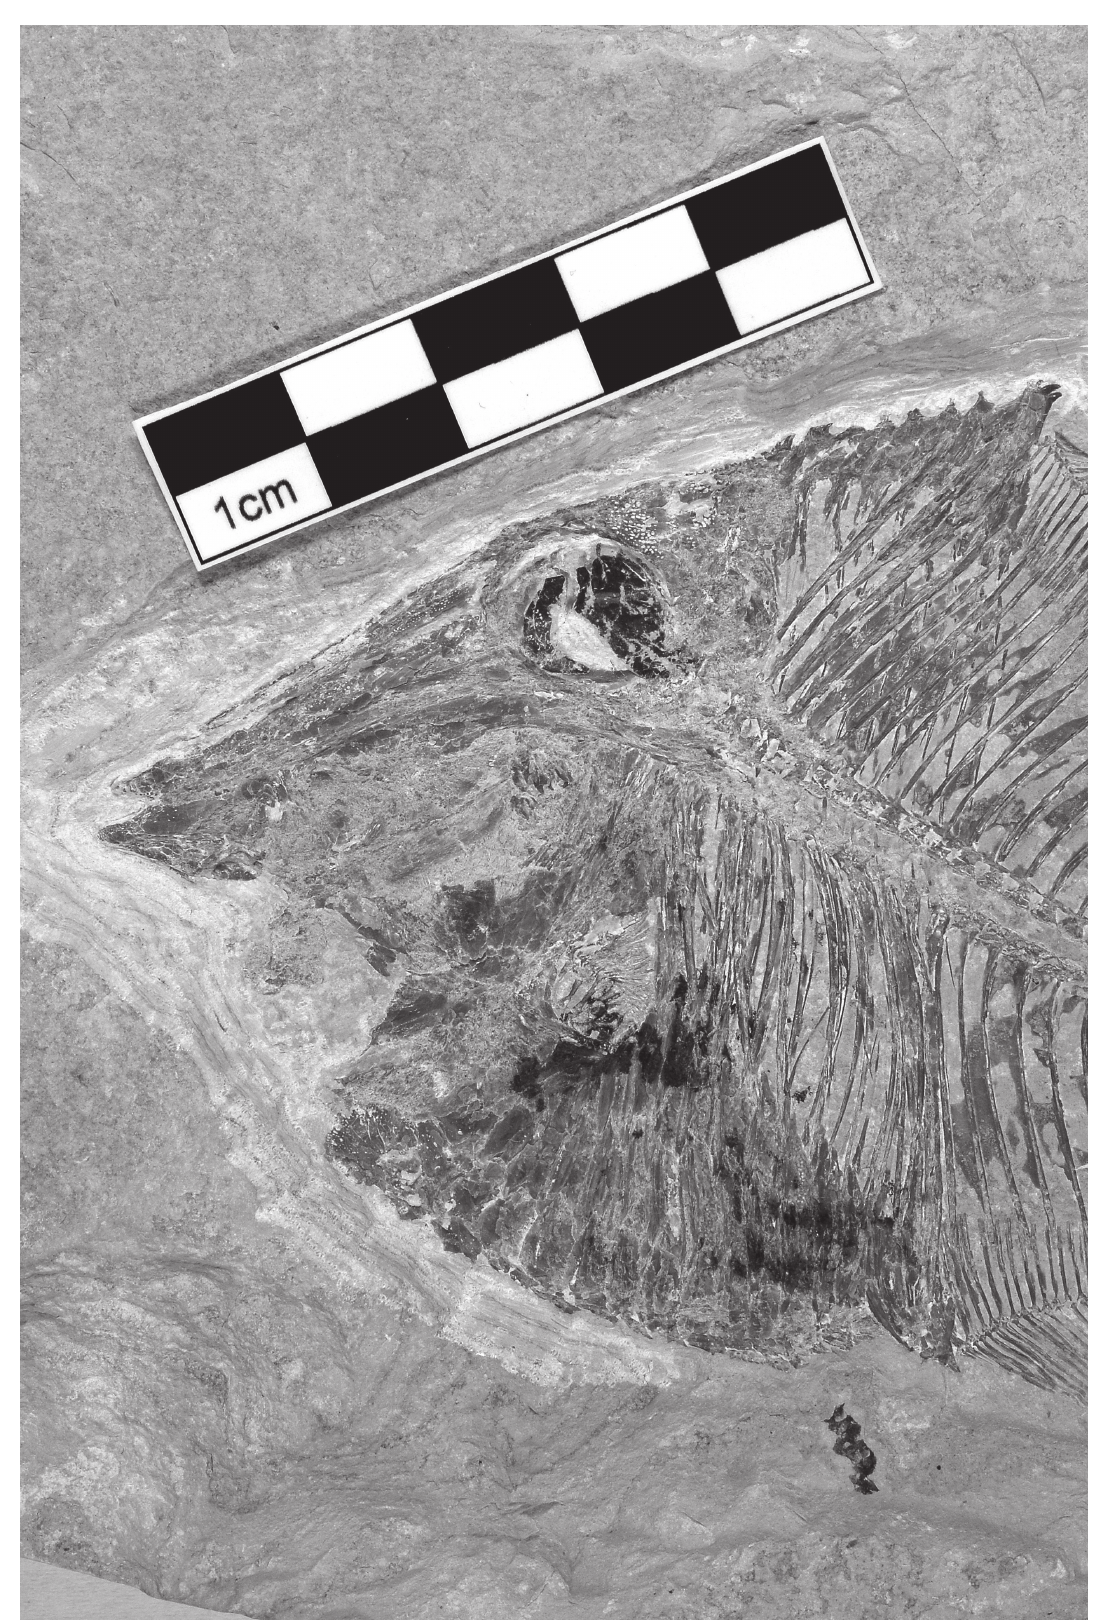
Fig. 8. Acrorhinichthys poyatoi gen. et sp. nov. Head and anterior region of paratype